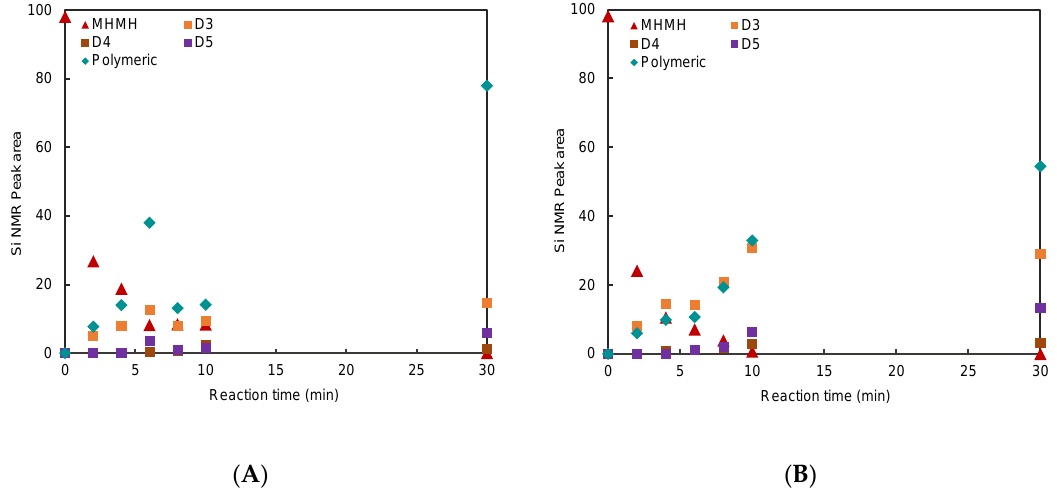
Figure 4. ( A ) Conversion to polymer without solvent. ( B ) Conversion to polymer in 50 wt% toluene. Rate of reaction (loss of HSi) during hydrolysis of M H M H was monitored using 1 H-NMR and silicone constituents using 29 Si-NMR. Integrations assumed identical sensitivity for all D units and are normalized to 100%.